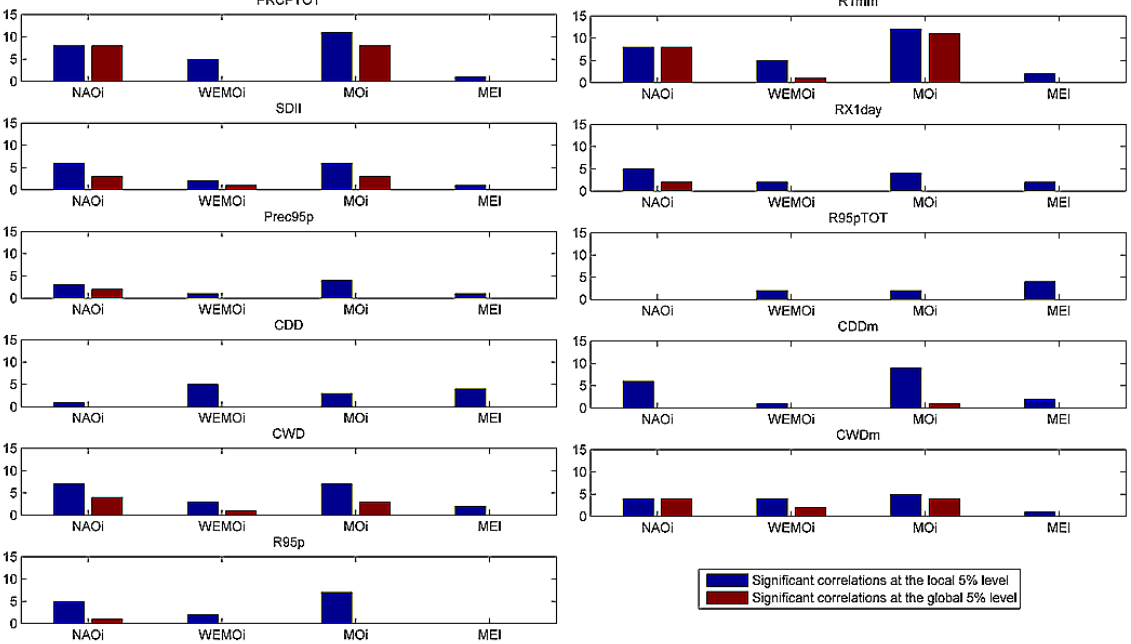
Fig. 9. Number of stations with significant correlations with the NAOi, WEMOi, MOi and MEi indices at the 5% local and global